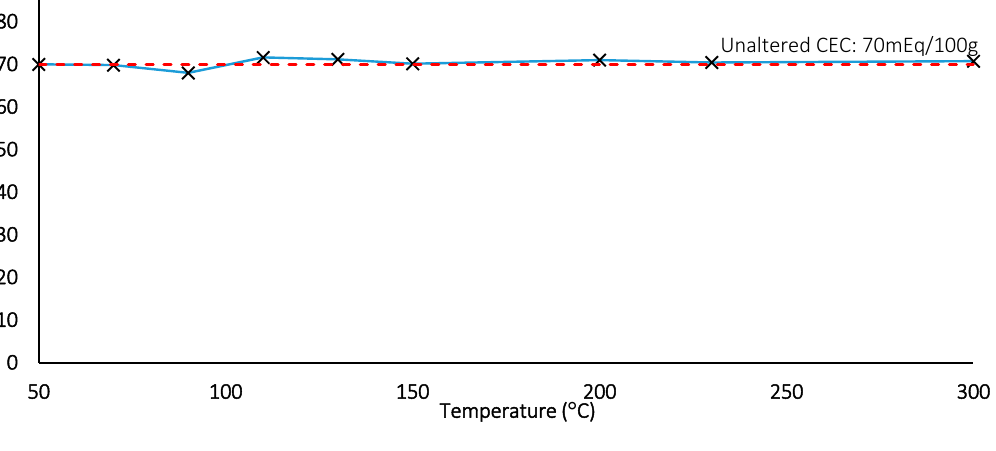
Figure 16. CEC measurements for thermal loading tests (Dotted line: control).